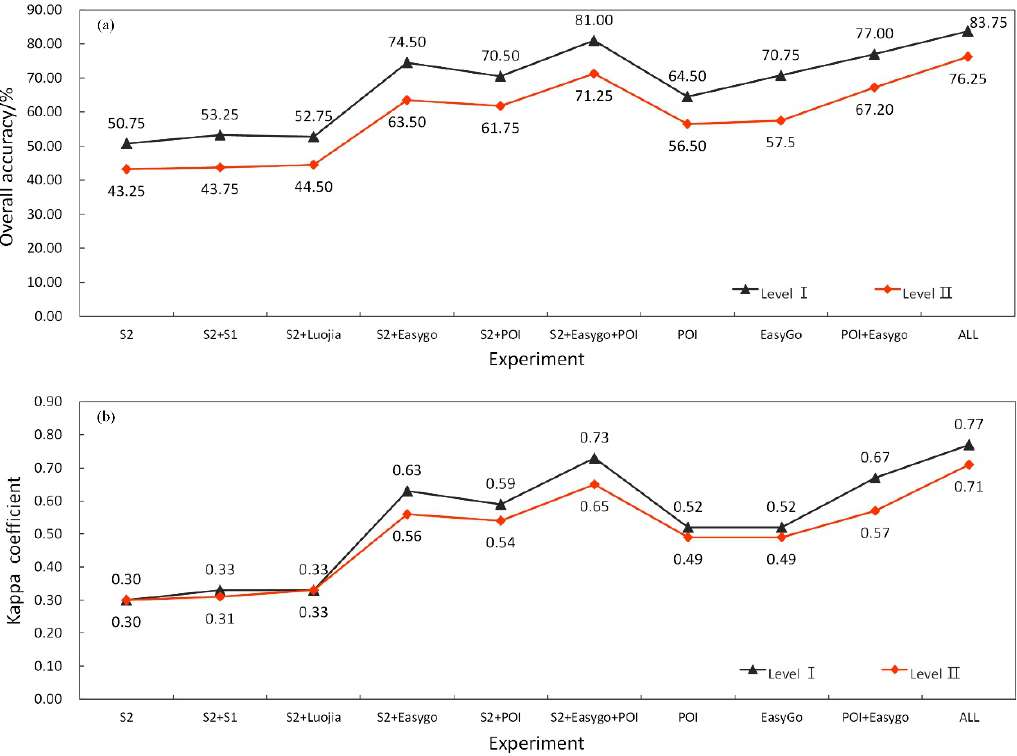
Figure 6. Overall accuracy ( a ) and kappa coefficient ( b ) of RF model based on different feature combinations.